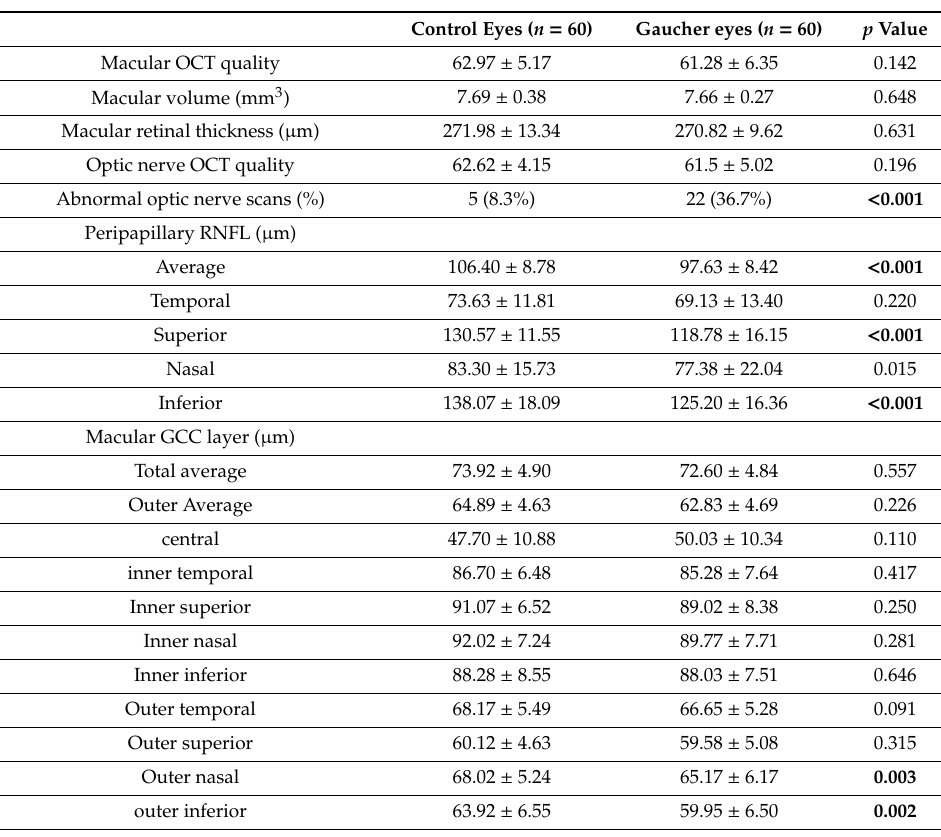
Table 2. Quality and data of macular and optic nerve optical coherence tomography scans of eyes of patients with type-1 Gaucher disease and control